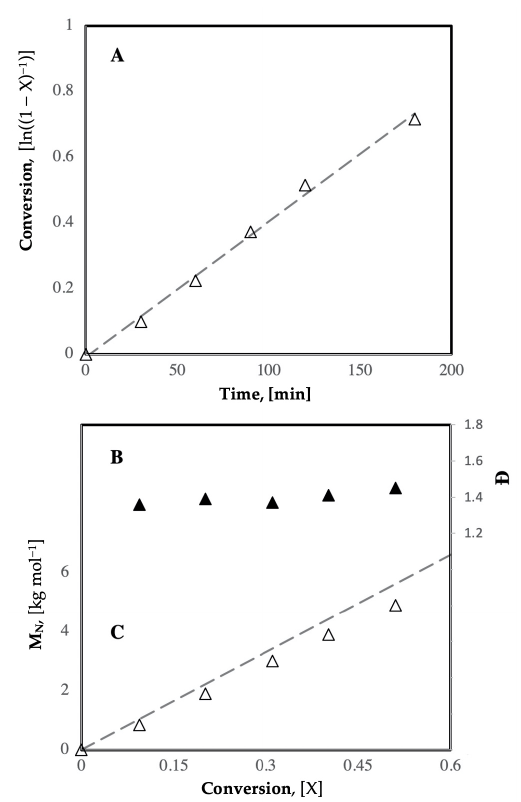
Figure 5. ( A ) Plots of the linearized conversion [ln(1 − X) −1 ] (X = conversion) versus time at 90 °C; ( B ) the dispersity (Ð) versus conversion (X); ( C ) the number average molecular weight (M N ) versus conversion (X) for the polymerization of vinylcaprolactam.